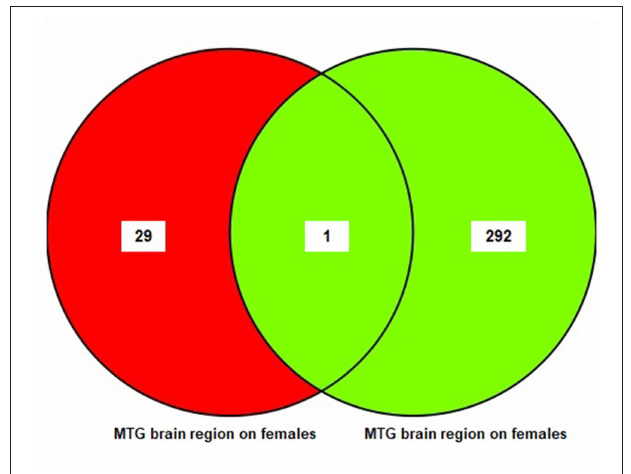
FIGURE 3 | The number of common genes obtained from entorhinal Cortex (EC) in females and males visualized by a Venn diagram.